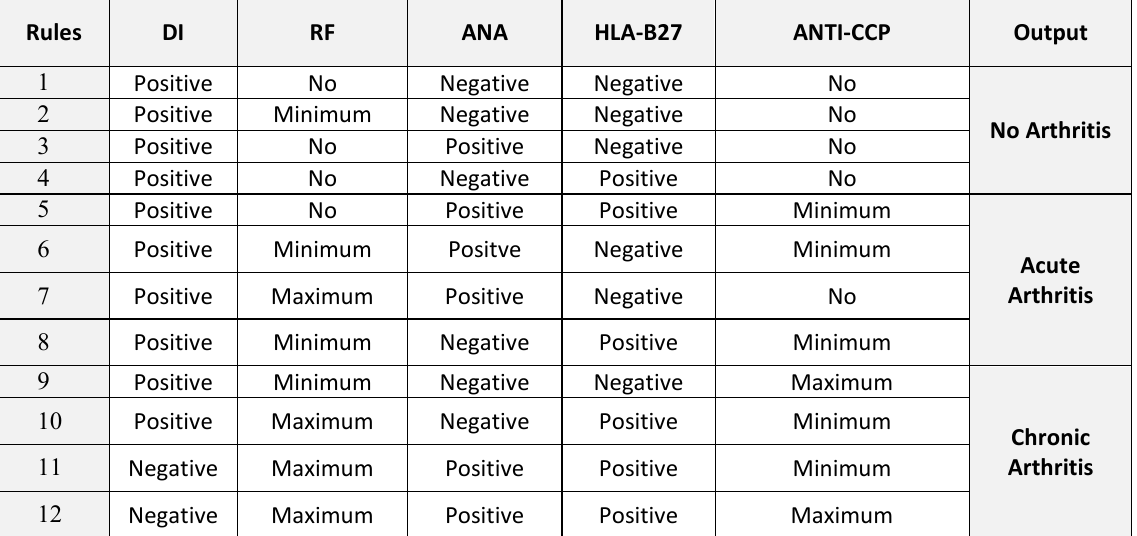
Table 8. Lookup Table of Layer –II for DA-AH-MFES Expert